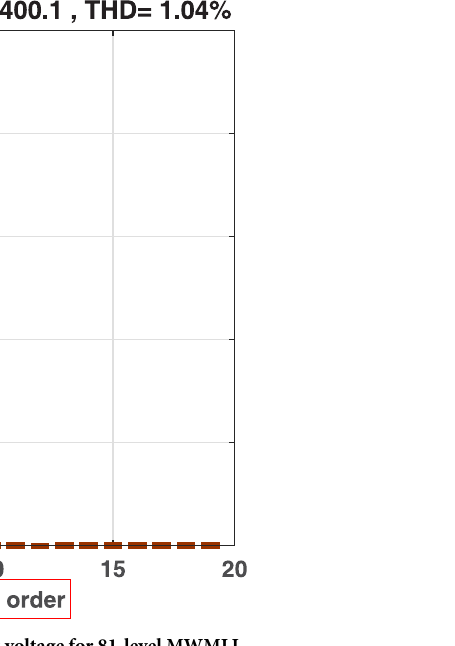
Fig 20. FFT and THD analysis of the output voltage for 81-level MWMLI.